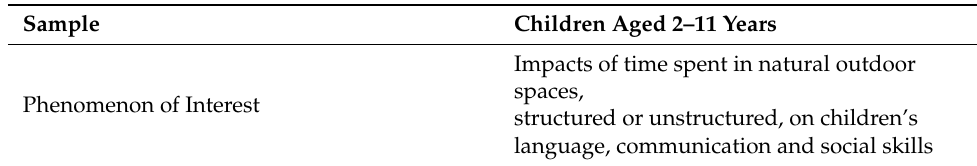
Table 1. Spider research question tool applied to prospective systematic review.